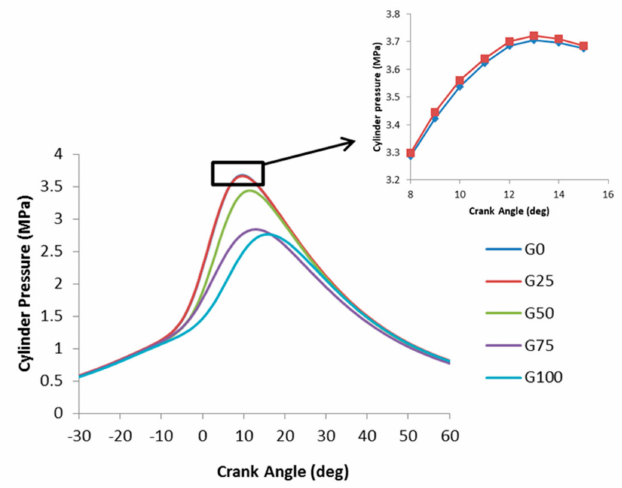
Figure 3. Cylinder pressure curve at di ff erent R e . (The direct injection timing is 180 ◦ CA BTDC (before top dead center). The ignition timing is MBT (minimum advance for best torque). The intake manifold absolute pressure is 42 kPa. The speed is 2100 r /